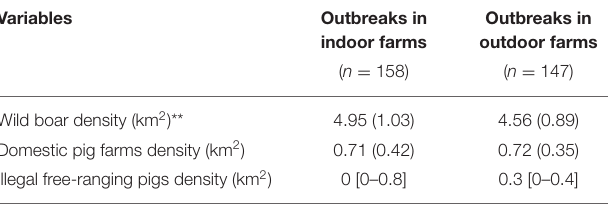
TABLE 2 | Descriptive statistics of the epidemiological context features based on 10km of radius around each outbreak farm, by farm type (indoor and outdoor).